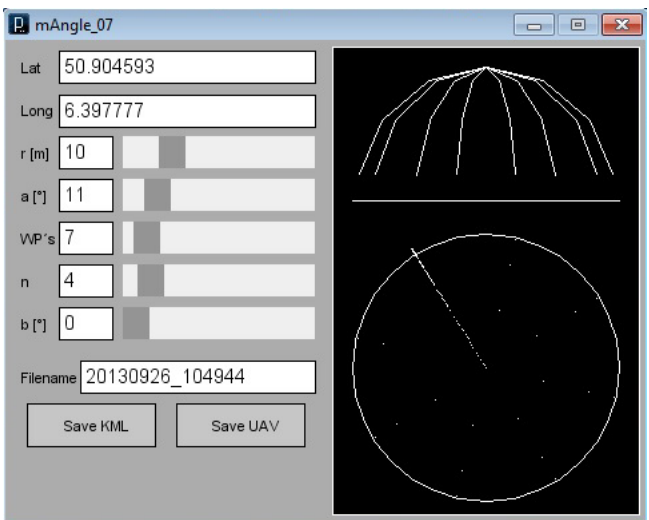
Figure 1. Graphical user interface of the mAngle software with input fields for the desired waypoint pattern. By setting radius, number of desired waypoints as well as starting